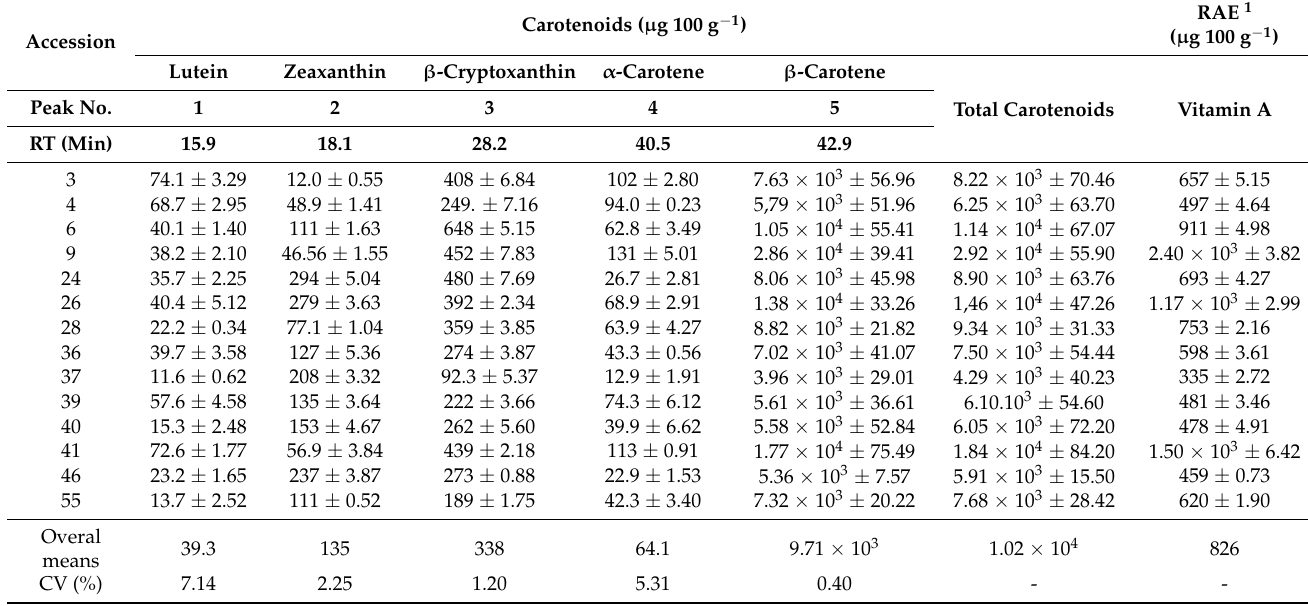
Table 3. Carotenoid content of the 14 uvaia accessions investigated in the present